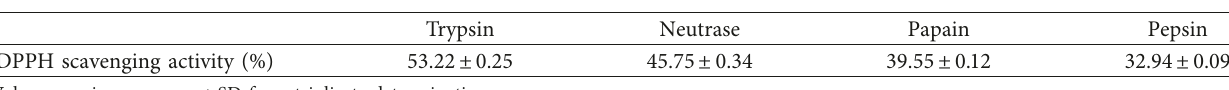
Figure 4: Scavenging effect of yak skin gelatin hydrolysates (YSGH) and reduced (b) effect on superoxide anion radicals; (c) effect on hydroxyl free radicals. Data displayed as average ± standard deviations from three Table 3: DPPH scavenging activity of yak skin gelatin hydrolysates by four-enzyme treatment under each optimum conditions. DPPH scavenging activity (%) Values are given as mean ± SD from triplicate determinations.